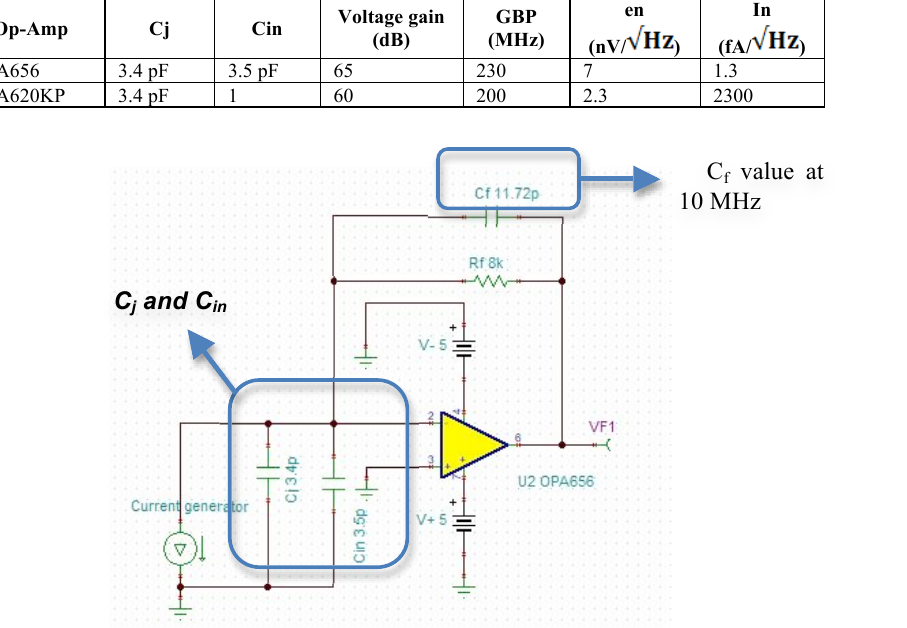
Fig. 2. TIA circuit in TINA TM -SPICE® in OPA656 simulation